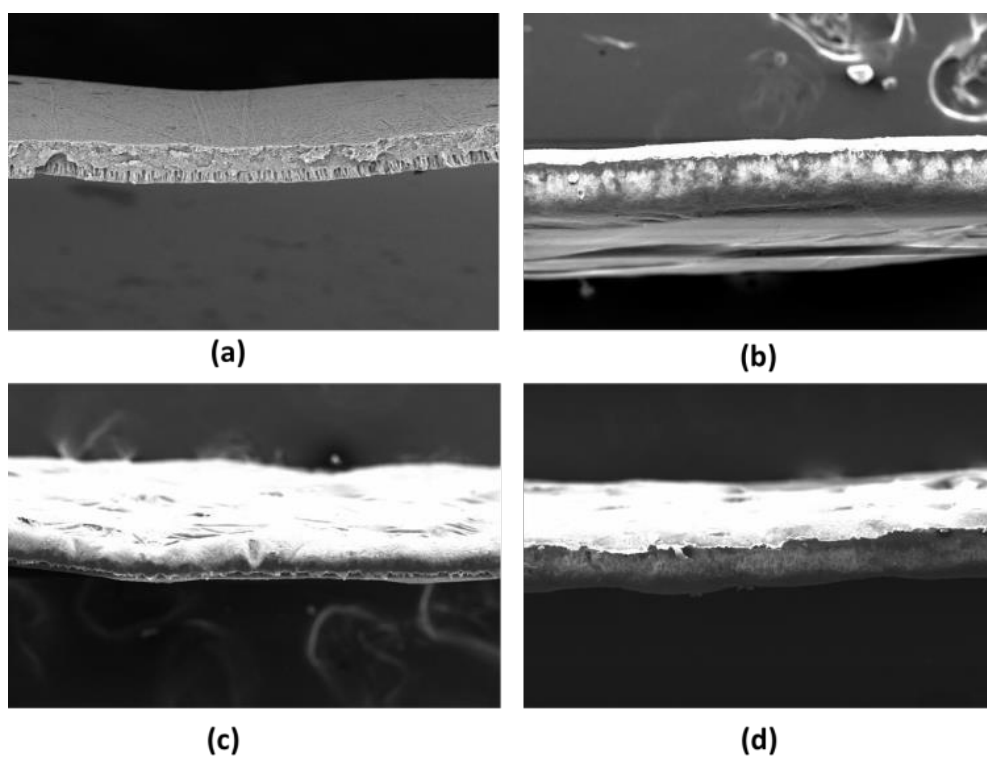
Figure 4. SEM results for the membrane cross section of ( a ) PVDF Pristine, ( b ) PVDF/PVP 14.8/0.2, ( c ) PVDF/PVP 14.85/0.15, and ( d ) PVDF/PVP 14.9/0.1 with a 100 × magnification.